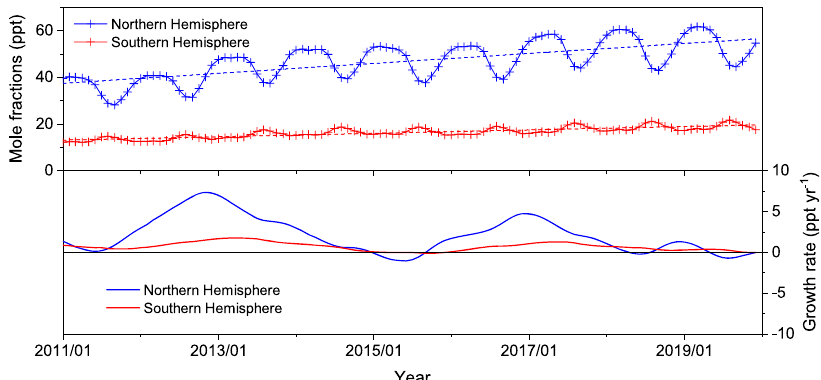
Fig. 1 Hemispheric mole fractions of CH 2 Cl 2 and their growth rate. Global mole fractions of CH 2 Cl 2 (2011 – 2019) were inferred using the AGAGE 12-box model and data from 5 AGAGE background sites (see Methods). The upper panel shows the mole fractions in each hemisphere and their trends (dashed lines). The lower panel shows the growth rate in each hemisphere, with a smoothing timescale of ~1.4 years 67 .